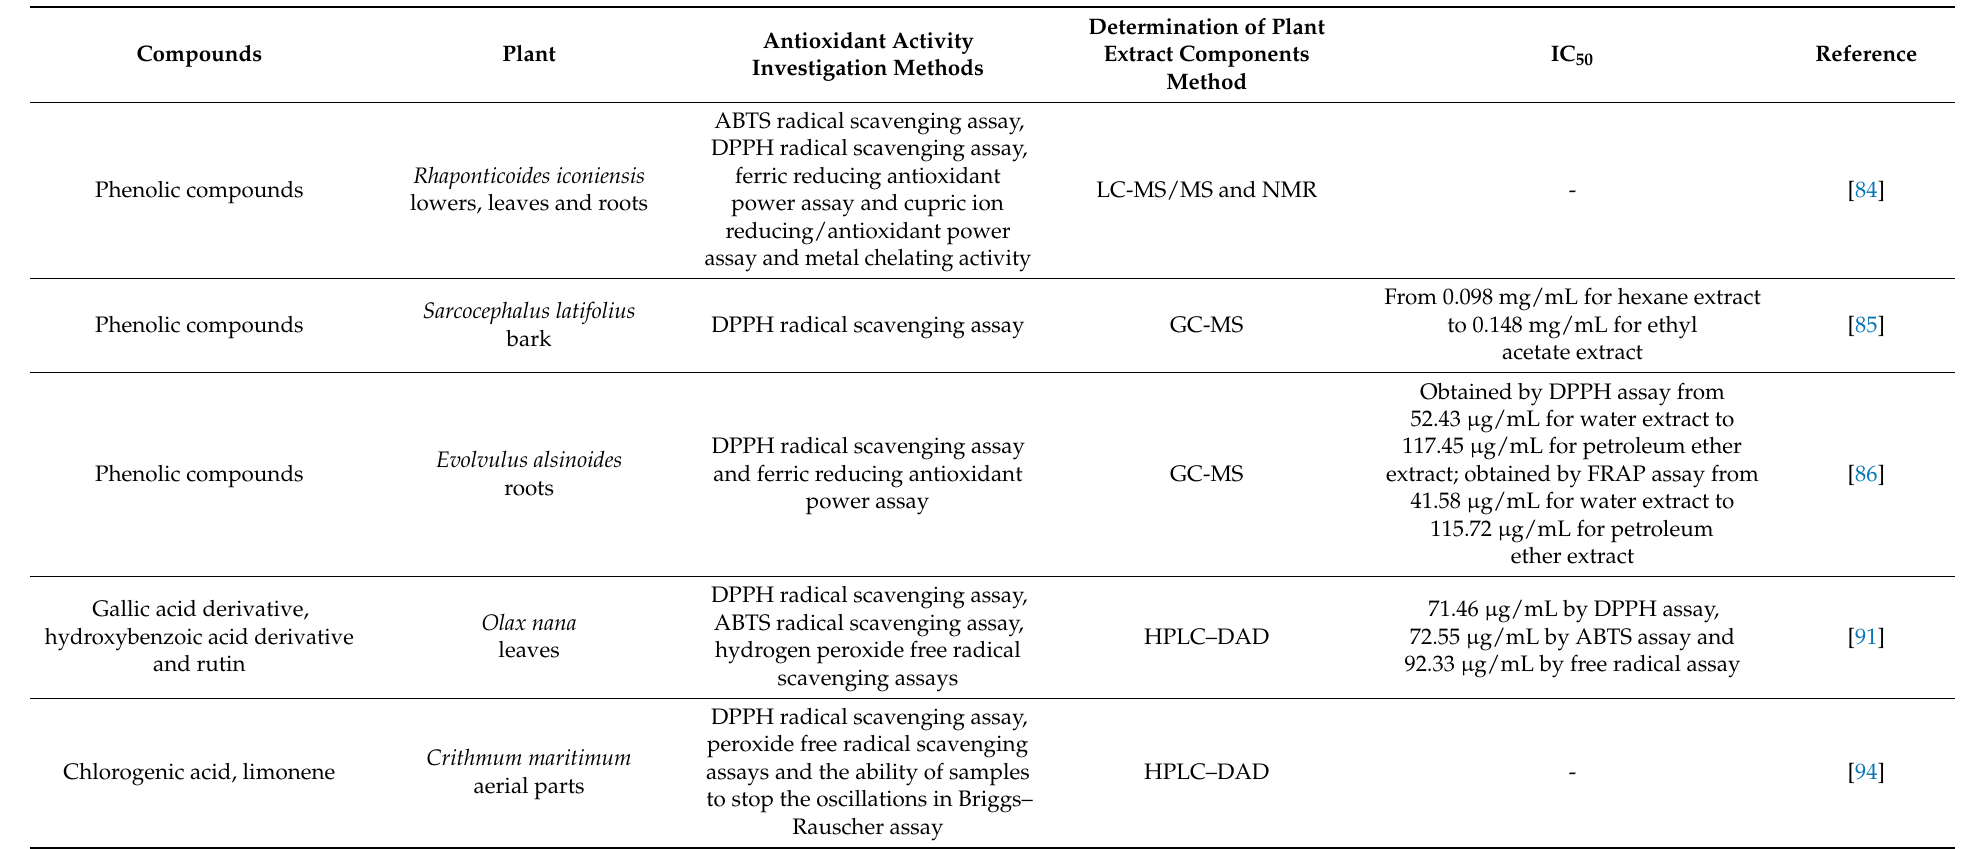
Table 3. Antioxidant activity of plant